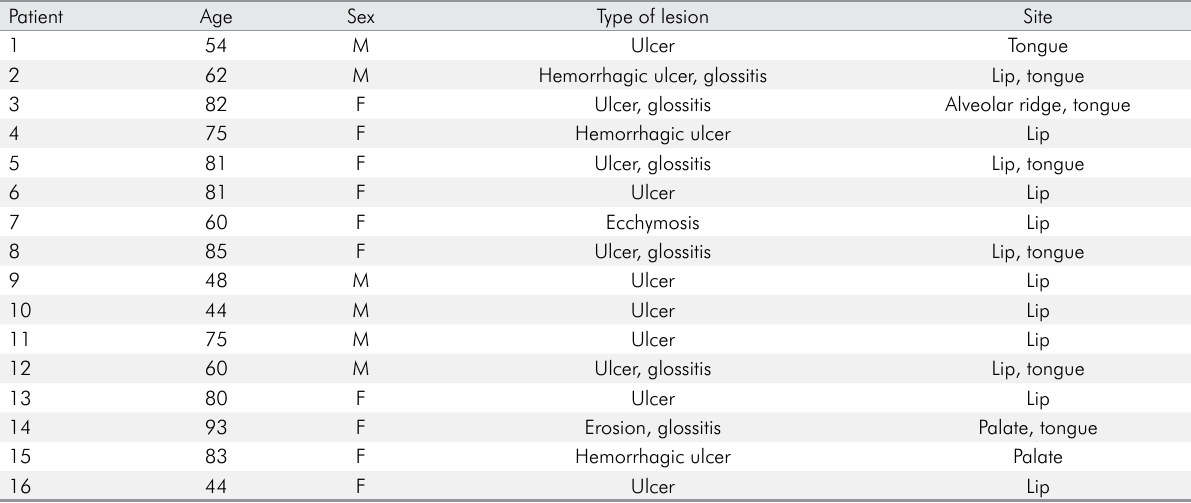
Table 3. Oral lesions in patients with COVID-19 admitted to the